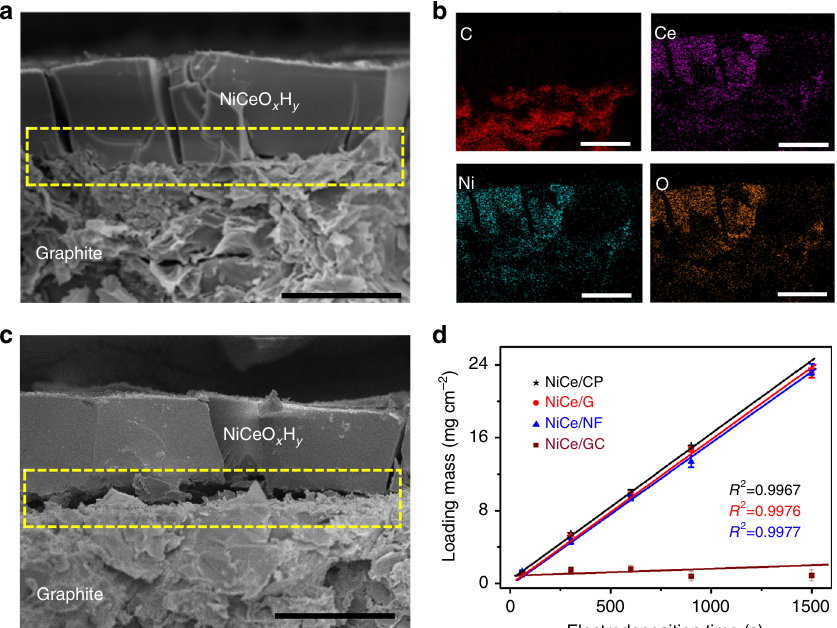
Fig. 3 Enhanced electrodeposition on nitrate-inserted graphite. a Cross-section SEM image of the prepared NiCeO x H y deposited on graphite after nitrate ion insertion. b Elemental mapping of C, Ce, Ni, and O. c Cross-section SEM image of NiCeO x H y directly deposited on graphite without foregoing anion intercalation. Scale bars, 25 μ m. d Relationship between the electrodeposition time and the loading mass of NiCeO x H y deposited on carbon paper (CP), graphite (G), nickel foam (NF), and glass carbon (GC). The electrodeposition was performed at a current density of − 20 mA cm − 2 in electrolyte containing totally 0.1 M Ni and Ce